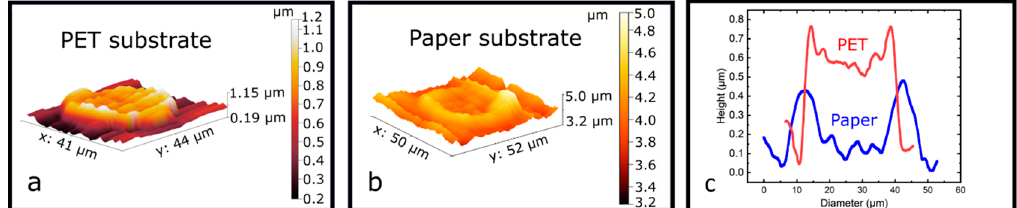
Figure A2. Spraying phenomenon observed on a pattern printed with a desktop inkjet printer on regular paper using standard coloured pigment ink. ( a ) The word “United”, printed, ( b ) zoom on the bottom part of the “i”, and ( c ) zoom on the bottom left corner of the “i”, showing spraying, comparable to the one observed with the CB ink.